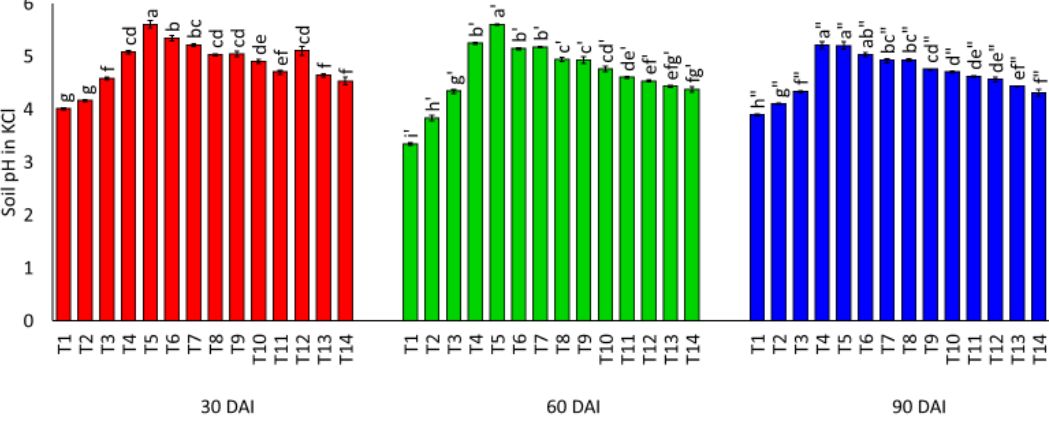
Figure 4. Effects of treatments on soil pH in potassium chloride after thirty, sixty, and ninety days of incubation, where T1: soil alone, T2: Egypt rock phosphate alone, T3: Egypt rock phosphate + 100% charcoal, T4: Egypt rock phosphate + 100% sago bark ash, and T5: Egypt rock phosphate + 100% charcoal + 100% sago bark ash, T6: Egypt rock phosphate + 75% charcoal + 75% sago bark ash, T7: Egypt rock phosphate + 50% charcoal + 75% sago bark ash, T8: Egypt rock phosphate + 25% charcoal + 75% sago bark ash, T9: Egypt rock phosphate + 75% charcoal + 50% sago bark ash, T10: Egypt rock phosphate + 50% charcoal + 50% sago bark ash, T11: Egypt rock phosphate + 25% charcoal + 50% sago bark ash, T12: Egypt rock phosphate + 75% charcoal + 25% sago bark ash, T13: Egypt rock phosphate + 50% charcoal + 25% sago bark ash, and T14: Egypt rock phosphate + 25% charcoal + 25% sago bark ash. Means with different letter(s) within the same incubation period indicate significant differences between treatments according to Tukey’s HSD test at p ≤ 0.05, i.e., a > b > c. Bars represent the mean values ± SE.